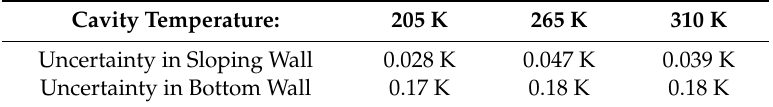
Table 3. Uncertainty of the temperatures of the emitting surfaces for 3 cavity temperatures. Cavity